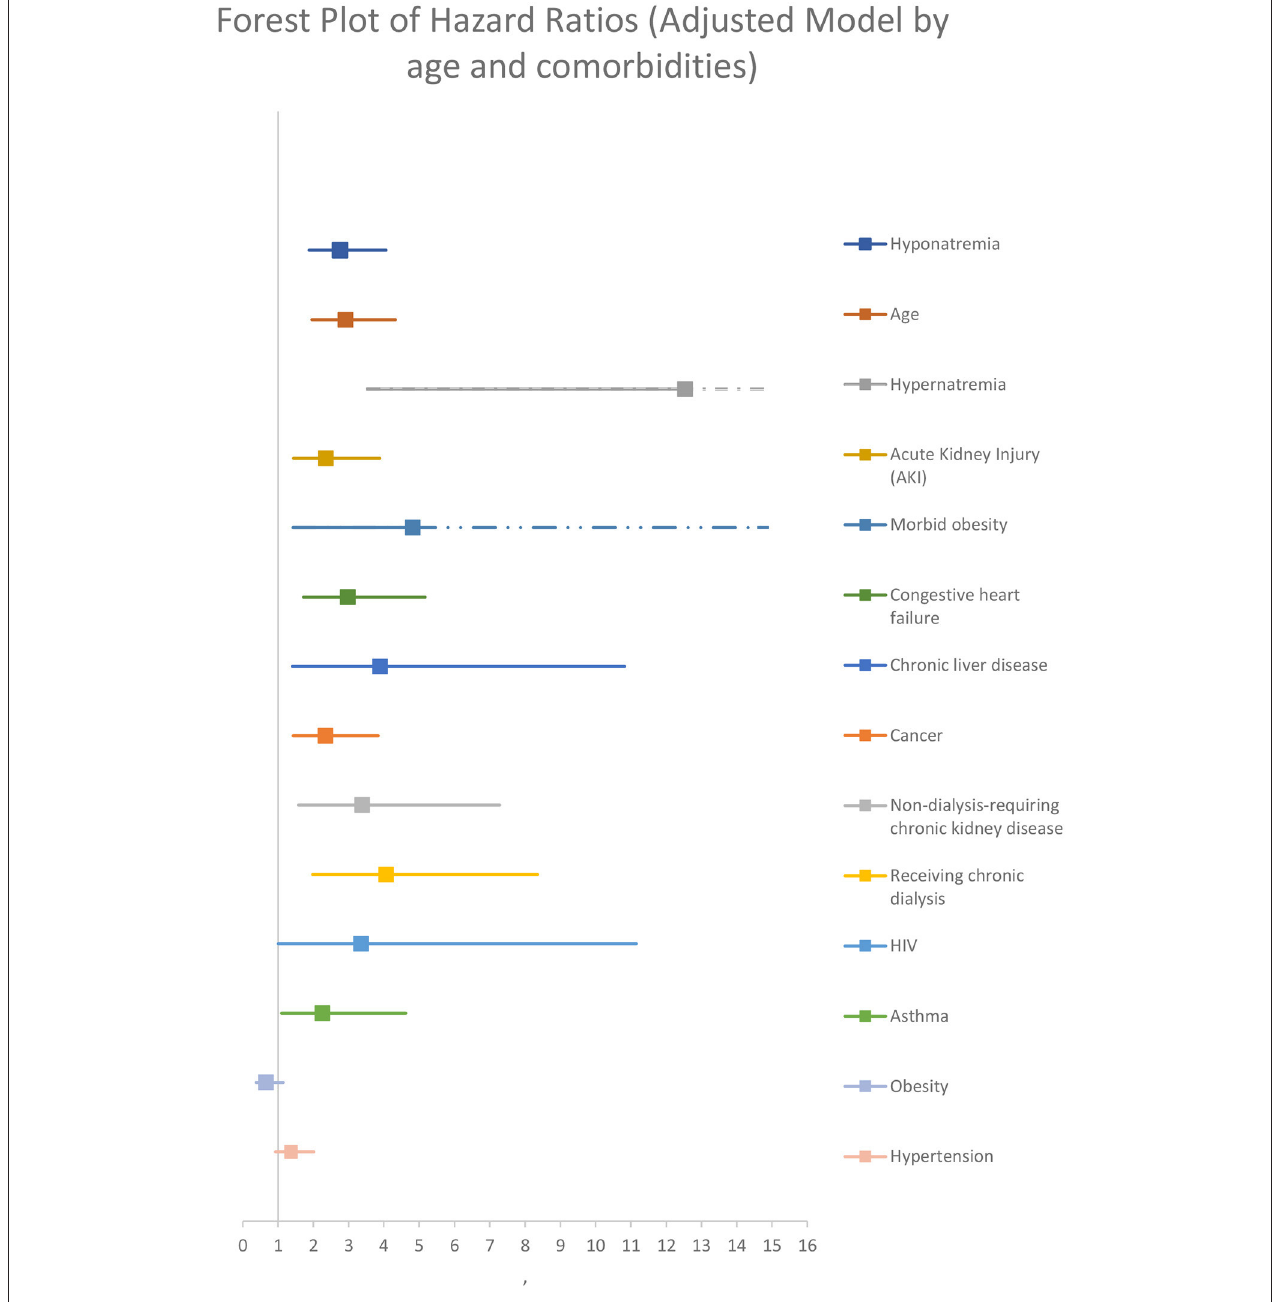
FIGURE 4 | Adjusted model by age and